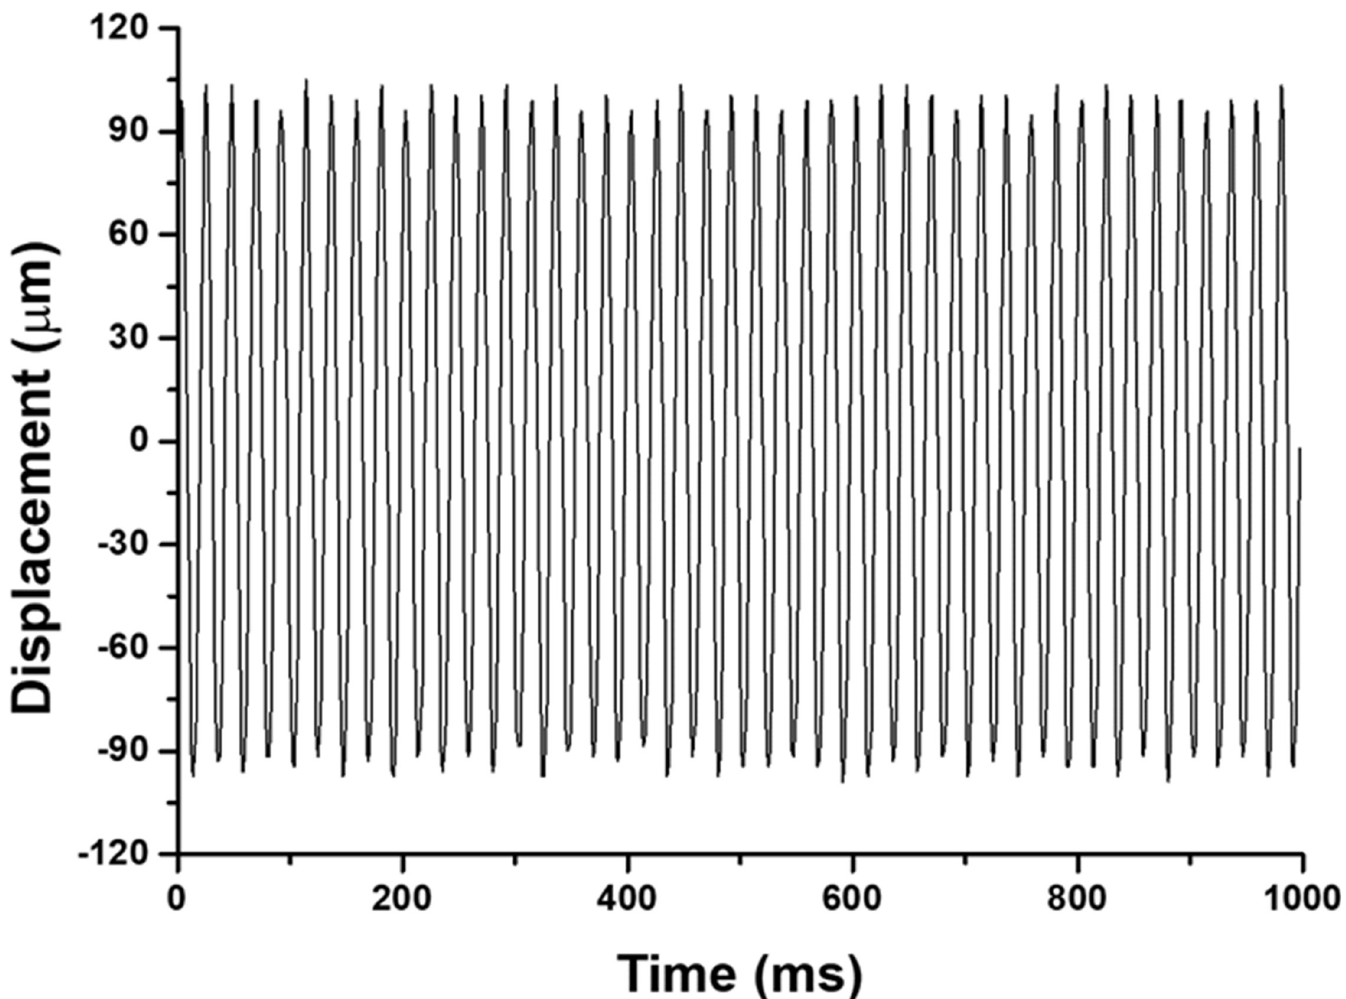
Fig 2. Vibrational characteristics at a frequency of 45 Hz with an acceleration of 0.8 g . Displacement of the sample over time was monitored by using computer